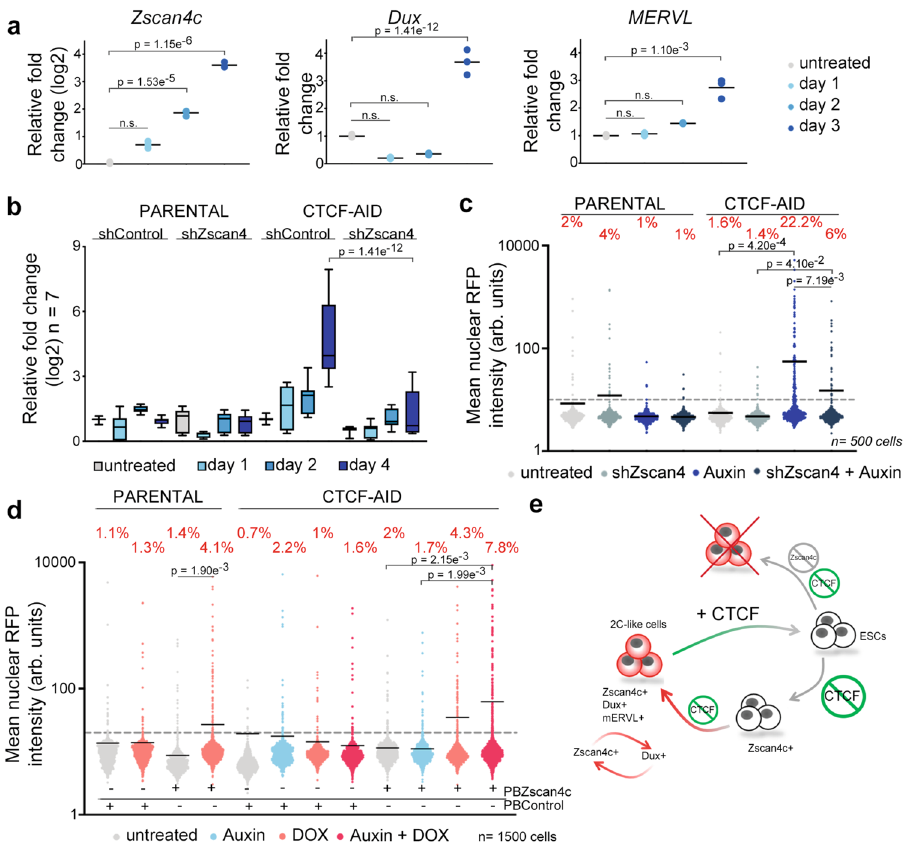
Fig. 5 Transcriptional activation of the ZSCAN4 cluster is required for 2C-like reprogramming. a Graph showing the relative fold change (log2 or linear) expression of DUX, ZSCAN4 and MERVL in untreated or auxin-treated LTR-RFP reporter ESC CTCF-AID for the indicated days. Center line shows the mean. Data are shown by triplicate. p -values are shown from two-tailed unpaired t -tests. n.s. = non-signi fi cant. b Box and whisker plot showing the averaged relative fold change (log2) expression of seven 2C-associated genes (DUX, ZSCAN4, ZFP352, TCSTV3, SP110, TDPOZ1 and MERVLs) in untreated or auxin-treated at the indicated time points in LTR-RFP reporter control and ESC CTCF-AID . ESC were infected with lentiviruses expressing control or shRNAs against ZSCAN4. Reactions were performed by triplicate in two independent experiments. Center line indicates the median, box extends from the 25 th to 75 th percentiles and whiskers show Min to Max values. p -values are shown from two-tailed paired t -tests. Group comparisons at Day 1 and Day 2 in ESC CTCF-AID are non-signi fi cant. All comparisons in parental cells are non-signi fi cant. c HTI quanti fi cation of RFP + cells in untreated or auxin-treated for four days LTR-RFP reporter control and ESC CTCF-AID . ESC were infected with lentiviruses expressing control or shRNAs against ZSCAN4. Center lines indicate mean values. n = 500; p -values are shown from two-tailed unpaired t -test. All comparisons in parental cells are non-signi fi cant. d HTI quanti fi cation of RFP + cells in untreated or auxin-treated for 24 h LTR-RFP reporter control and ESC CTCF-AID . ESC harbor a DOX-inducible piggyBac (PB) construct expressing ZSCAN4C and were induced with 1 μ g/mL DOX as indicated together with auxin for 24 h. Center lines indicate mean values. n = 1500; p -values are shown from two-tailed unpaired t -tests. e Schematic representation of the model inferred from the data presented here. In a – d , one representative experiment is shown but two independent experiments were performed with similar results. In c , d percentages of RFP + cells above the threshold are